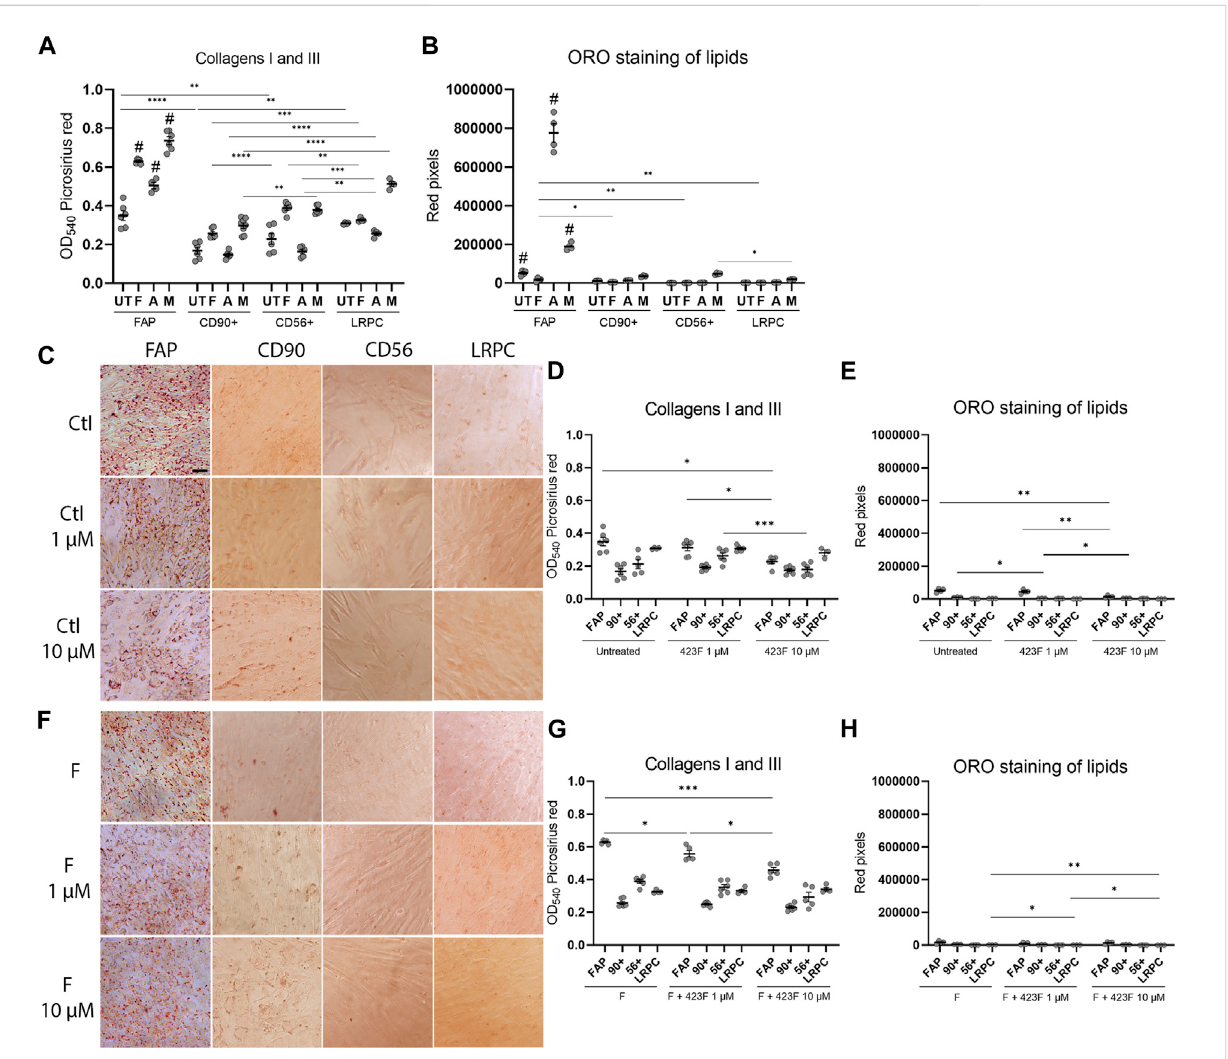
FIGURE 3 423F elicits greater inhibition of human muscle FAP fi bro-adipogenic differentiation than that of CD56, CD90, and LRPC in control and fi brogenic cultures. Picrosirius red spectrophotometric quanti fi cation of collagen production (A, D, G) and red pixel quanti fi cation of Oil red O-stained adipocytes (B, E, H) at the indicated conditions (UT = untreated, F = fi brogenic, A = adipogenic, M = myogenic) in the presence or absence of 1 uM and 10 µM 423F. Data (mean ± SEM) was pooled frommultipleexperiments with triplicates for all cultures (n= atleast3per cell subset). Representativeimages of Oil Red O-stained adipogenic cells in control (C) and fi brogenic cultures (F) for each cell subset. Data was analyzed via paired one-way ANOVA for comparisons betweenthesamecell subset and unpaired one-wayANOVA for comparisonsbetweendifferentcell subsets, followed by Tukey ’ s post hoc multiple comparisons. # denotes signi fi cance between FAP and all other subsets in the matched culture conditions. # p < 0.0001, **** p < 0.0001, *** p < 0.001, ** p < 0.01, * p < 0.05. Scale bar represents 100 μ m.